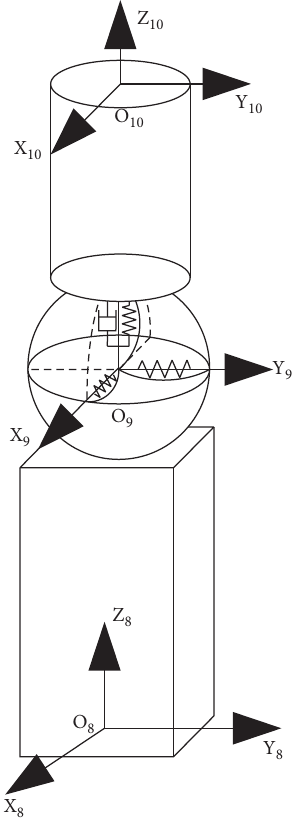
Figure 9: Schematic diagram of the one branch of the 3-UPU parallel vibration isolator.